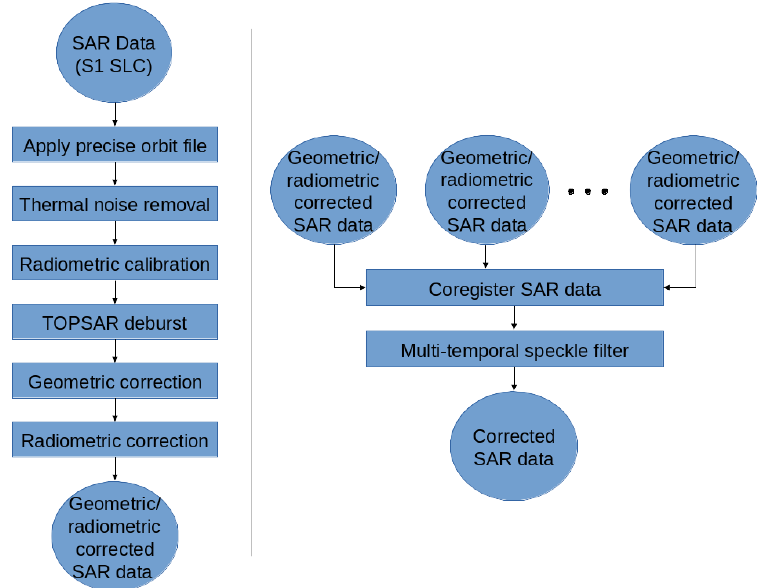
Figure 2. Schematic overview of SNAP pre-processing steps to retrieve geometric and radiometric corrected images from Sentinel-1 SLC data ( left ). Pre-processing steps for speckle reduction using a multi-temporal speckle filter ( right